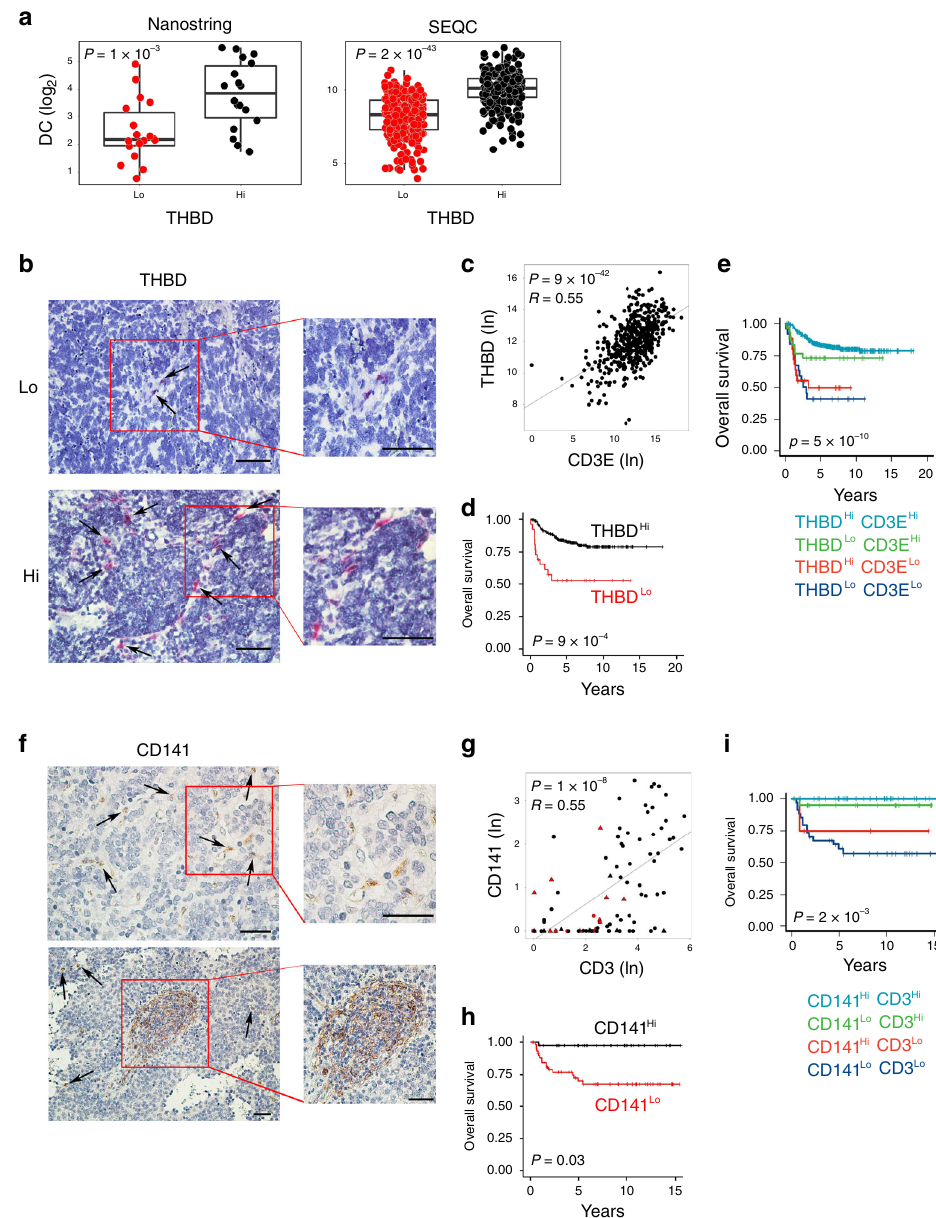
Fig. 3 Intratumoral DC levels correlate with increased survival in human neuroblastoma. a Box plots of the DC gene signature 28 according to the high and low levels of THBD gene expression (median split) in primary NB lesions from Nanostring-NB ( n = 36) and SEQC-NB ( n = 498) cohorts. DC signature score was calculated as the average expression values of the NanoString constituent genes. The boxes show the 25th to 75th percentile; the horizontal lines inside the box represent the median; the upper whisker extends to the largest data point, no more than 1.5 times the IQR from the box; the lower whisker extends to the smallest data point at most 1.5 times the IQR from the box; the dots are individual samples. Data were analyzed by Kruskal – Wallis rank-sum test (two-sided). b Representative images of NB tissue sections analyzed for THBD expression using RNAscope (red dots). Nuclei were counterstained with hematoxylin (blue). THBD positive cells are indicated by black arrows. Original magni fi cation ×40 (left) and ×60 (right). Scale bar, 30 μ m. c Correlation between THBD and CD3E gene expression in NB patients, analyzed by robust F-test (two-sided) in SEQC-NB ( n = 498). d , e Kaplan – Meier curves show the duration of overall survival of NB patients according to the THBD gene expression either alone ( d ), or in combination with CD3E gene ( e ) in SEQC-NB ( n = 498). Log-rank test with Miller and Siegmund P -value correction was used. f Representative examples of CD141 staining in primary NB lesions. Upper and lower panels, CD141-expressing cells sparsely distributed within tumor nests or localized within TLS, respectively. Brown, CD141-expressing cells. Nuclei were counterstained with hematoxylin (blue). CD141 positive cells are indicated by black arrows. Original magni fi cations, ×40 (up left), ×60 (up right), ×20 (down left), and ×40 (down right). Scale bars, 30 μ m. g Scatter plot showing the correlation between CD141 + and CD3 + cell densities in NB patients, analyzed by robust F-test (two-sided). Black and red dots, patients who are alive and dead, respectively; triangle and dots, MYCN ampli fi ed and non-ampli fi ed patients, respectively. h , i Kaplan – Meier curves of overall survival of NB patients ( n = 104) according to the density of CD141 + cells alone ( h ) or in combination with CD3 + cell densities ( i ). Log-rank test with Miller and Siegmund P -value correction was used. Correlations in c and g were assessed measuring the coef fi cient of determination of a robust linear regression model fi t on the data (see “ Statistical analysis"). The representative images in b and f were selected from n = 104 biologically independent NB specimens. Hi high, Lo low. No adjustment was required unless otherwise stated. Statistically signi fi cant P values are